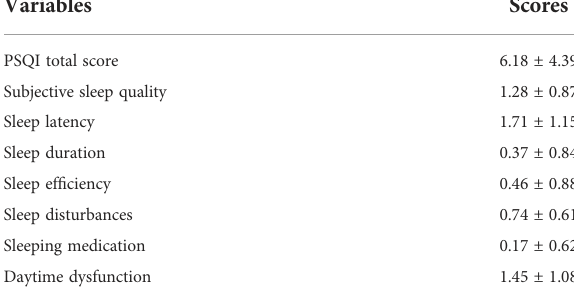
TABLE 5 Pittsburgh Sleep Quality Index scores in lung cancer patients with chemotherapy (N = 302).